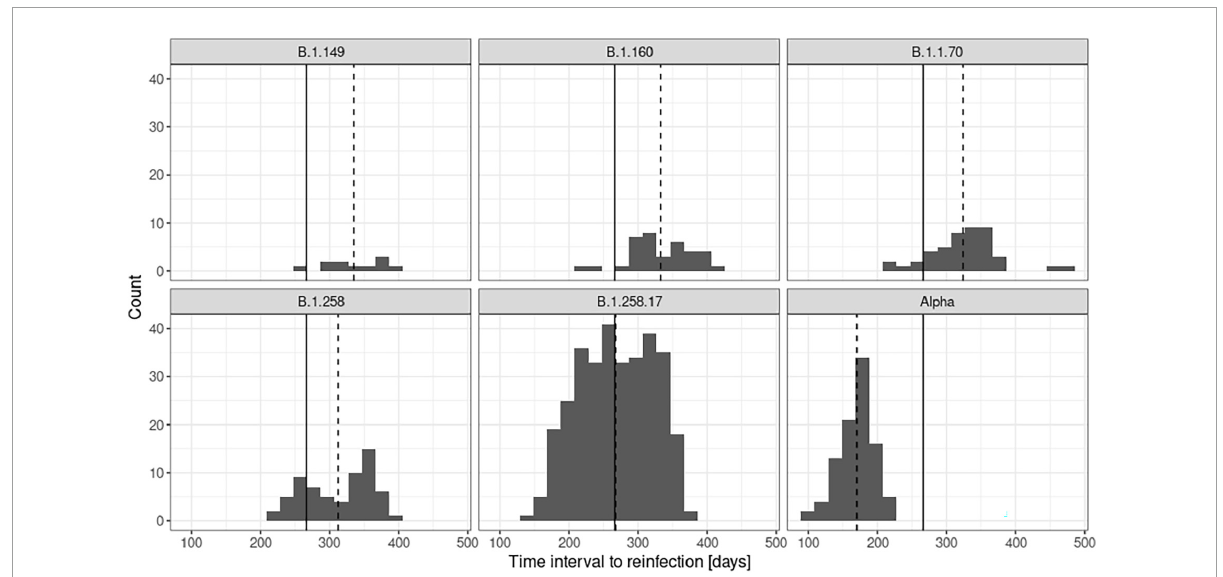
FIGURE3 Time intervals between first infection and reinfection for the most common variants observed in primary infection in cases. The global mean of the time intervals between infections across all variants is shown as a solid line, and the mean interval for each variant is shown as a dashed